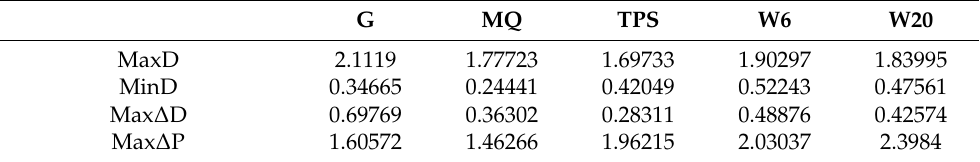
Figure 5. Rotation results obtained using the basis functions. Table 6. Comparison of the modification